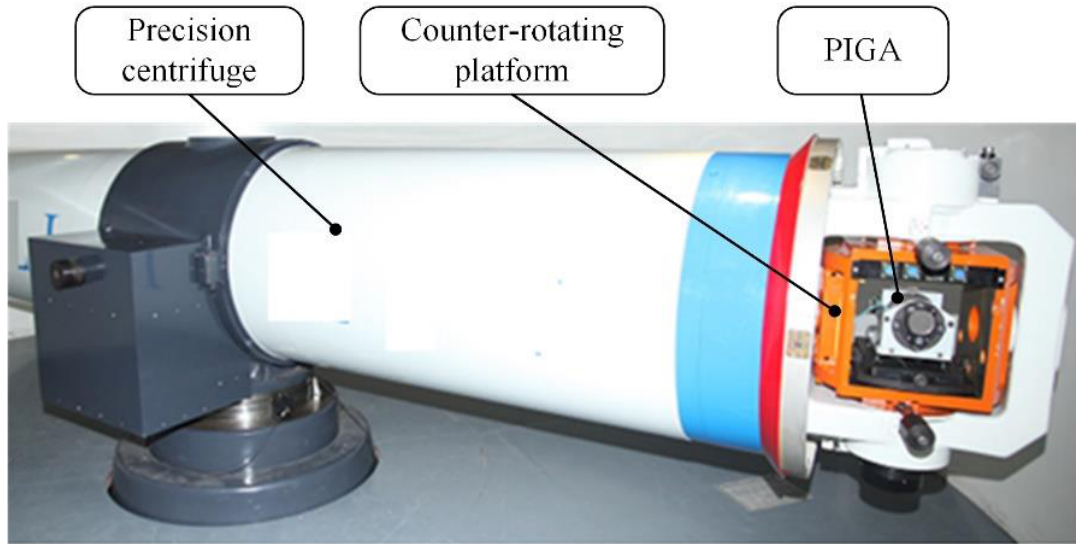
K . Figure 9. Experimental setup for calibration of K 2 2